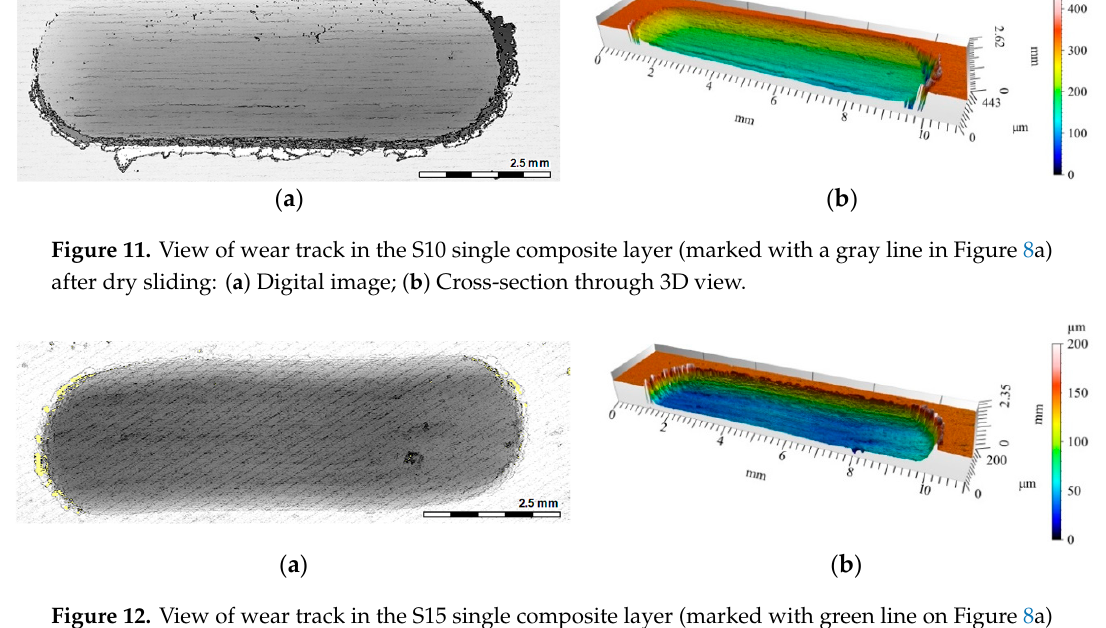
Figure 12. View of wear track in the S15 single composite layer (marked with green line on Figure 8a) after dry sliding: ( a ) Digital image; ( b ) Cross-section through 3D view.